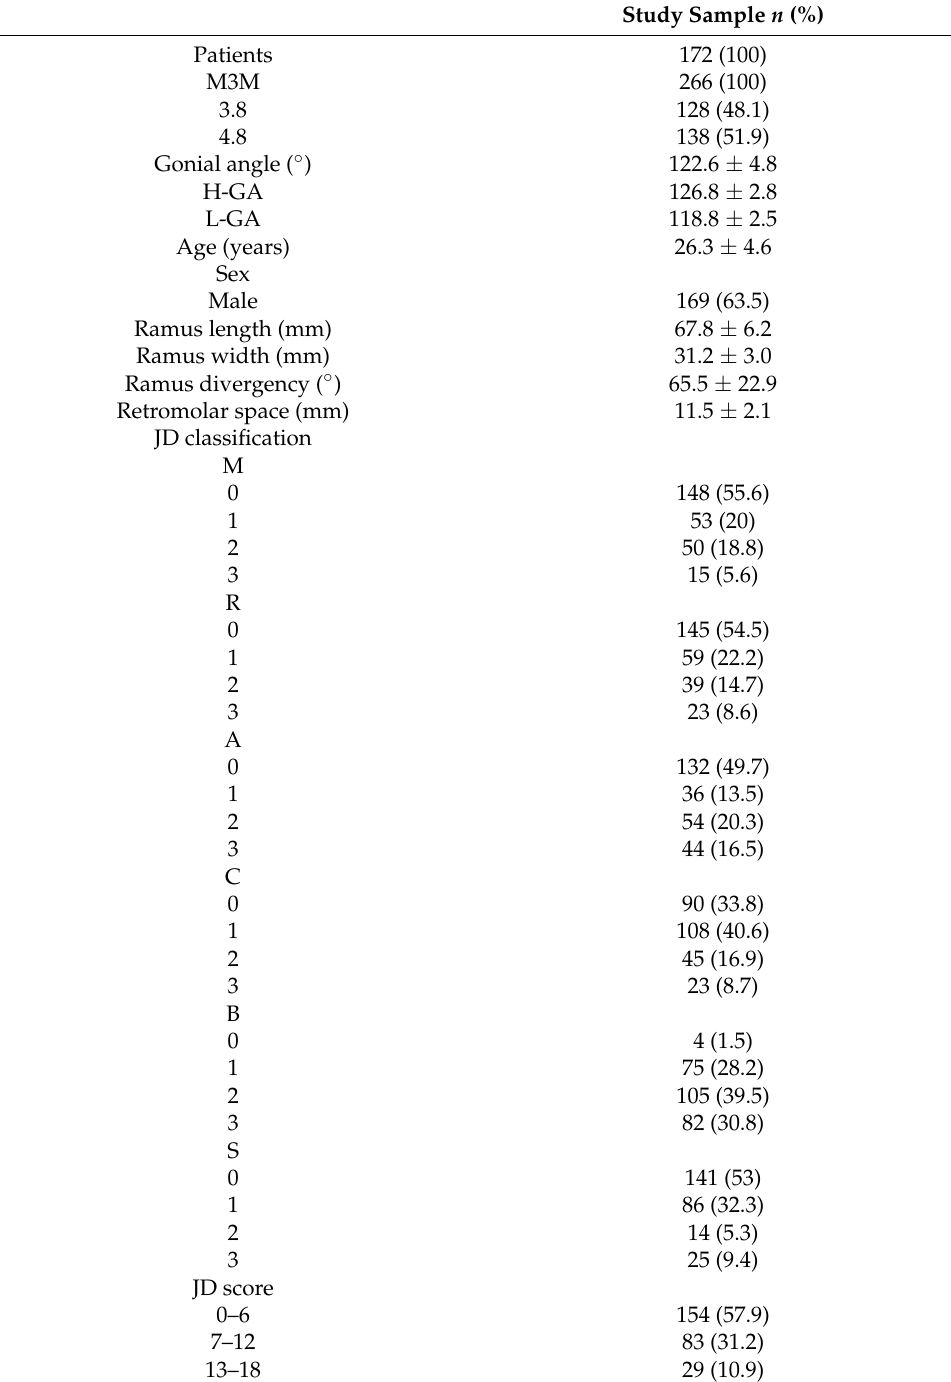
Table 1. Descriptive statistics of the study